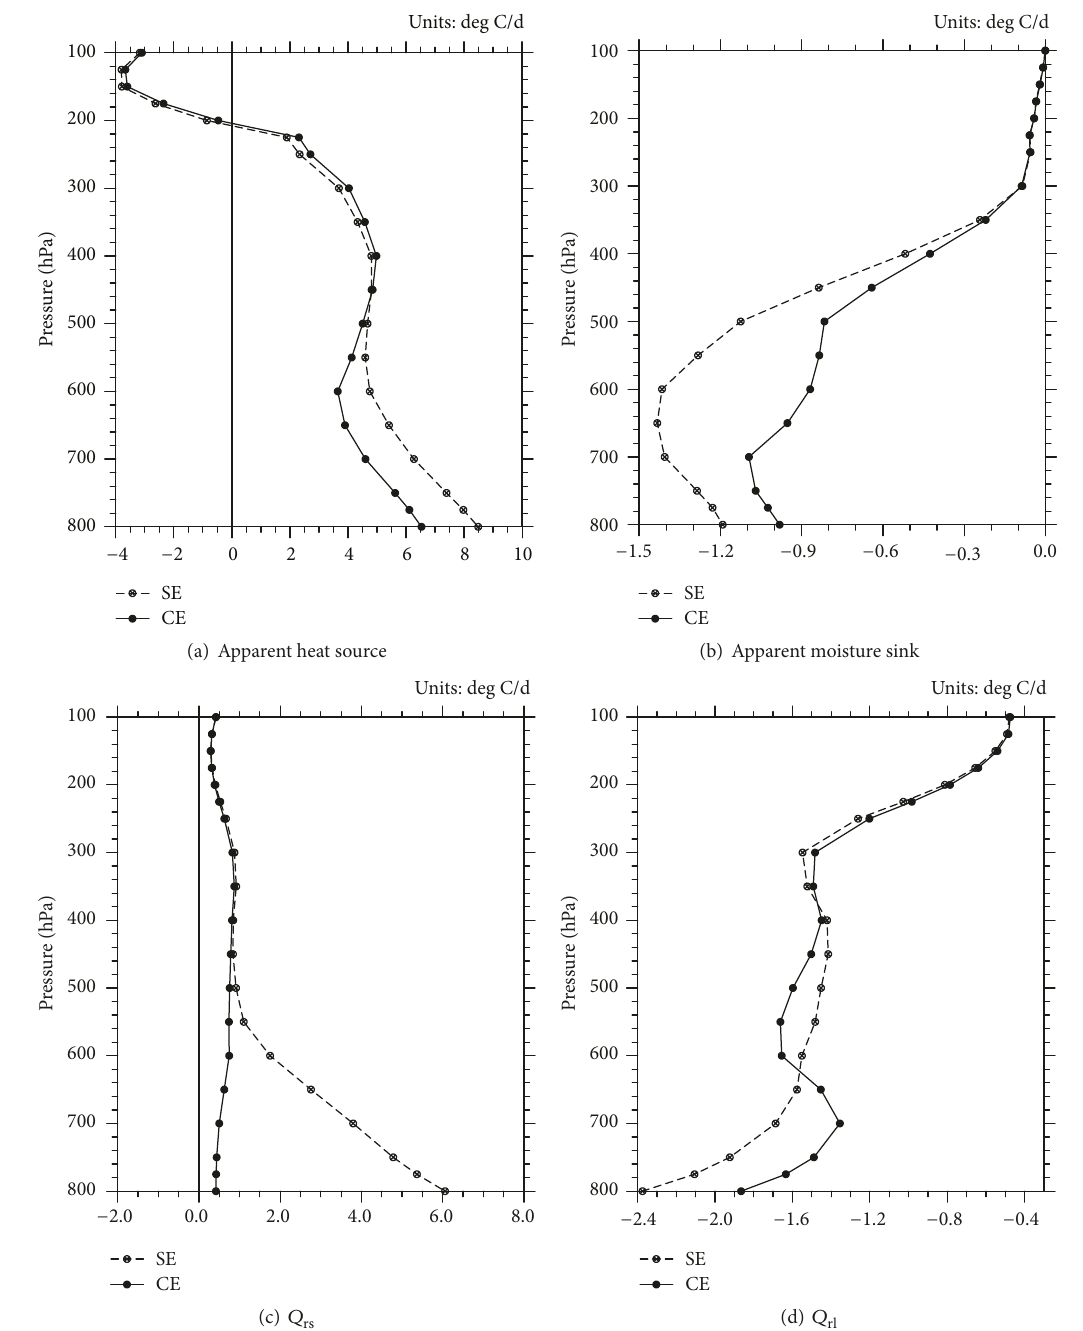
Figure 9: The vertical profile of (a) apparent heat source ( 𝑄 1 /( ∘ Cd −1 )); (b) apparent moisture sink ( 𝑄 2 /( ∘ Cd −1 )); (c) shortwave radiation heating rate ( 𝑄 rs /( ∘ Cd −1 )); (d) longwave radiation heating rate ( 𝑄 rl /( ∘ Cd −1 )) in SE and CE, respectively, in April averaged from 2001 to